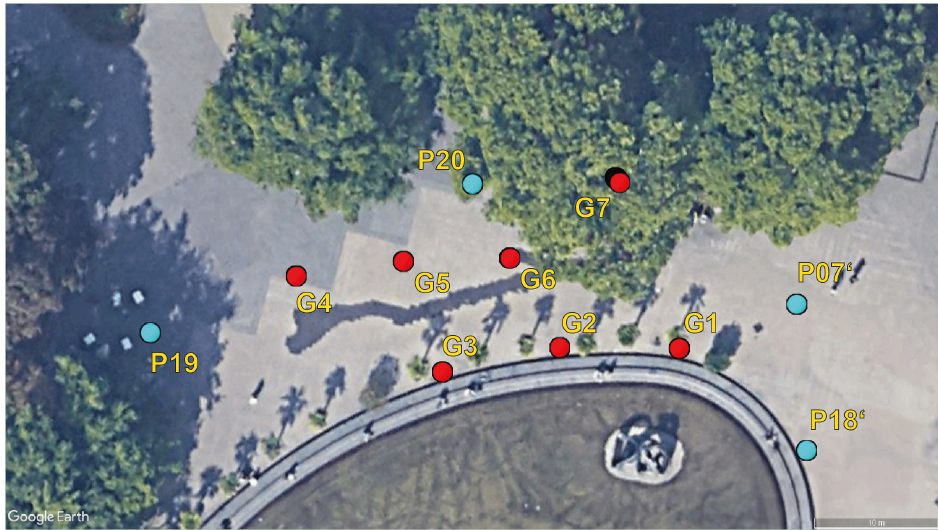
Figure 9. Survey area in a